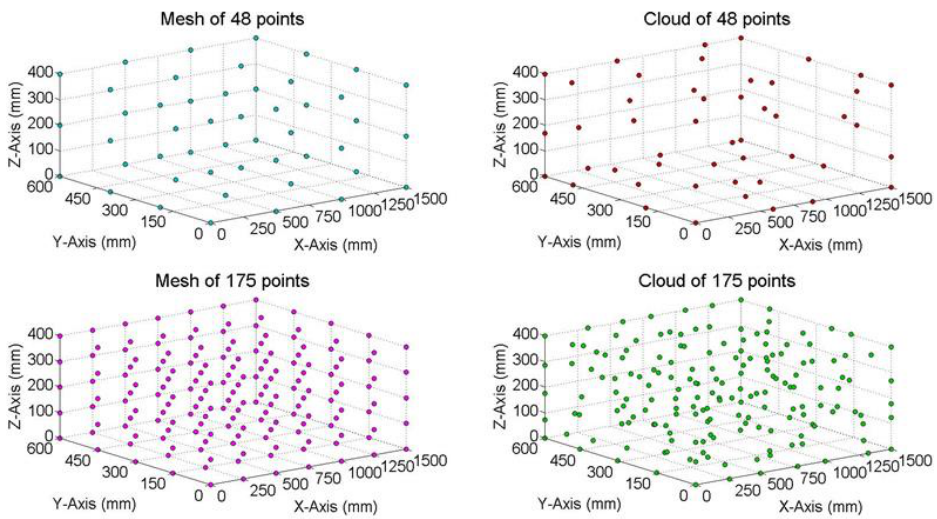
Figure 5. Distribution and number of points studied.